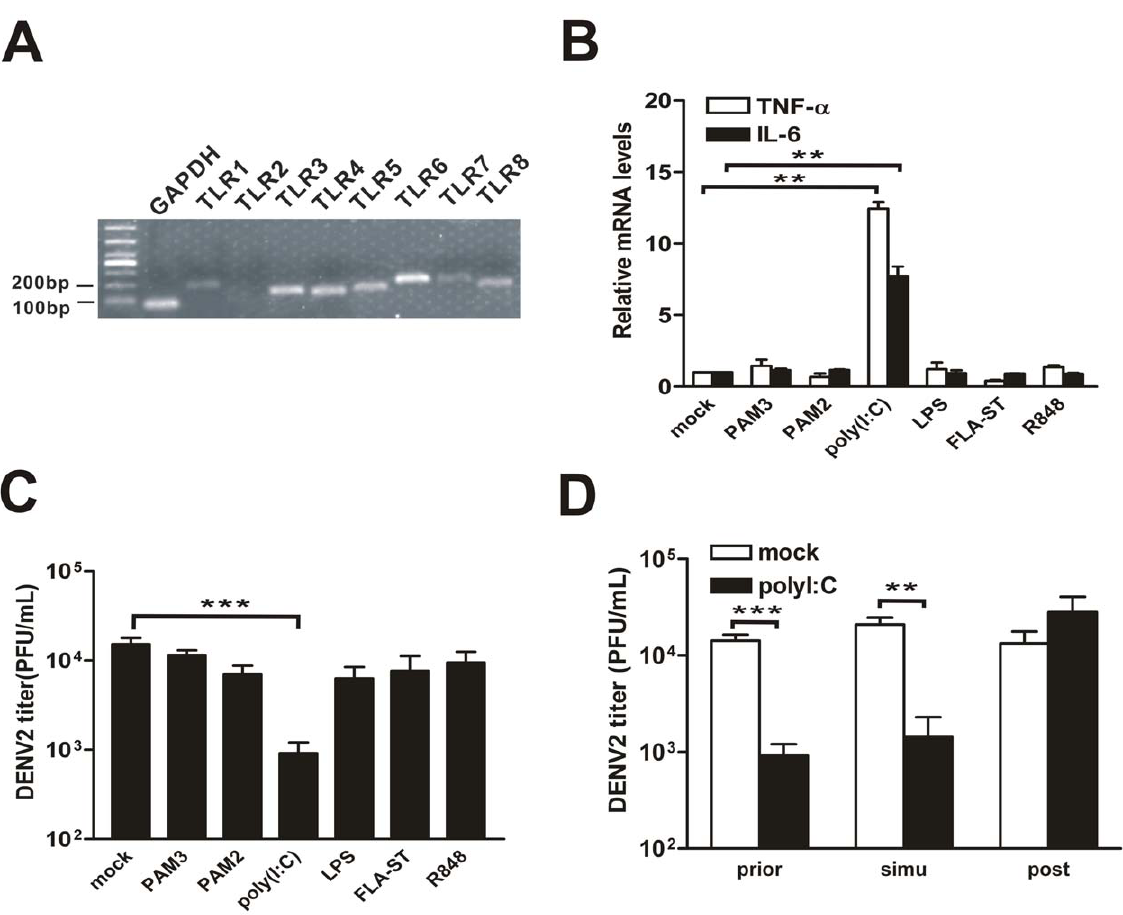
Figure 1. Effect of TLR ligands on DENV2 replication in HepG2 cells. (A) Endogenous TLR expression in HepG2 cells. (B) Induction of IL-6 and TNF- a in response to TLR ligands. HepG2 cells were pretreated with individual TLR ligands for 9 h. (C) Extracellular virus yields. HepG2 cells were pretreated with individual TLR ligands and infected by DENV2 for 24 h. (D) Extracellular virus yields. HepG2 cells were pretreated with poly(I:C) at 9 h prior to, simultaneously (simu), or 9 h post DENV2 infection. Supernatants were harvested at 24 h p.i. and titered on C6/36 cells. Error bars represent the standard error of mean from the average of three experiments. Student’s t test, **, p , 0.01; ***, p , 0.001.